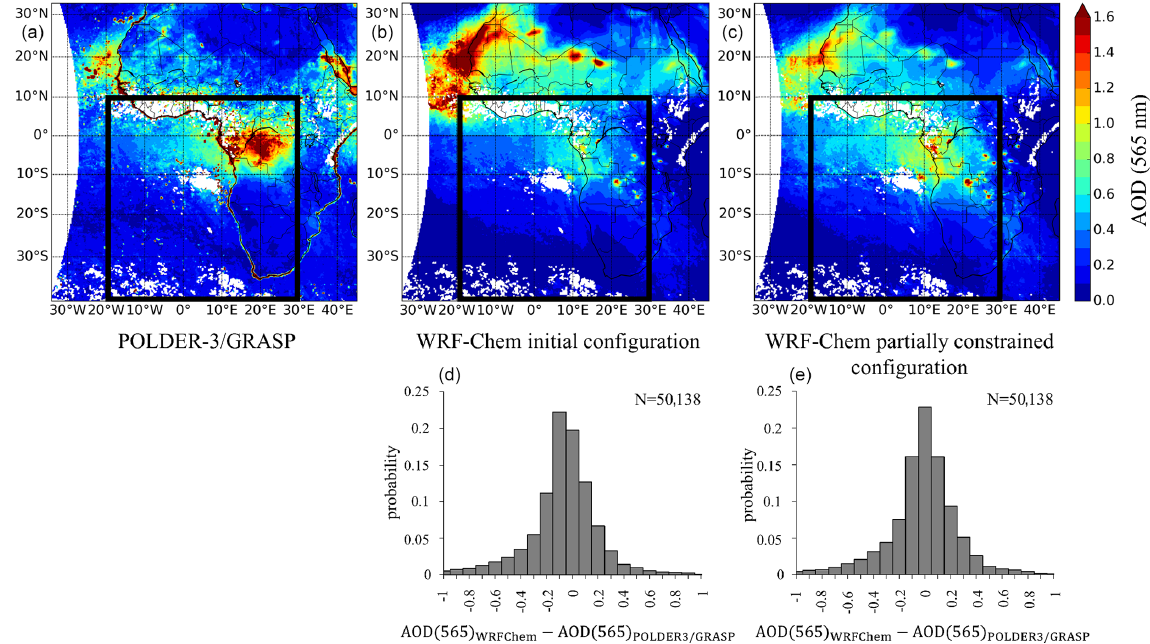
Figure 7. Monthly averaged aerosol optical depth (AOD) at 565nm in clear sky retrieved by POLDER-3/GRASP (a) and simulated with the WRF-Chem initial configuration (b) and with the WRF-Chem partially constrained configuration (c) for July 2008, with the associated histograms of differences between the model and the satellite observations over the whole domain (d, e) . The black frames (20 ◦ W–30 ◦ E, 39.9 ◦ S–10 ◦ N) represent the area of